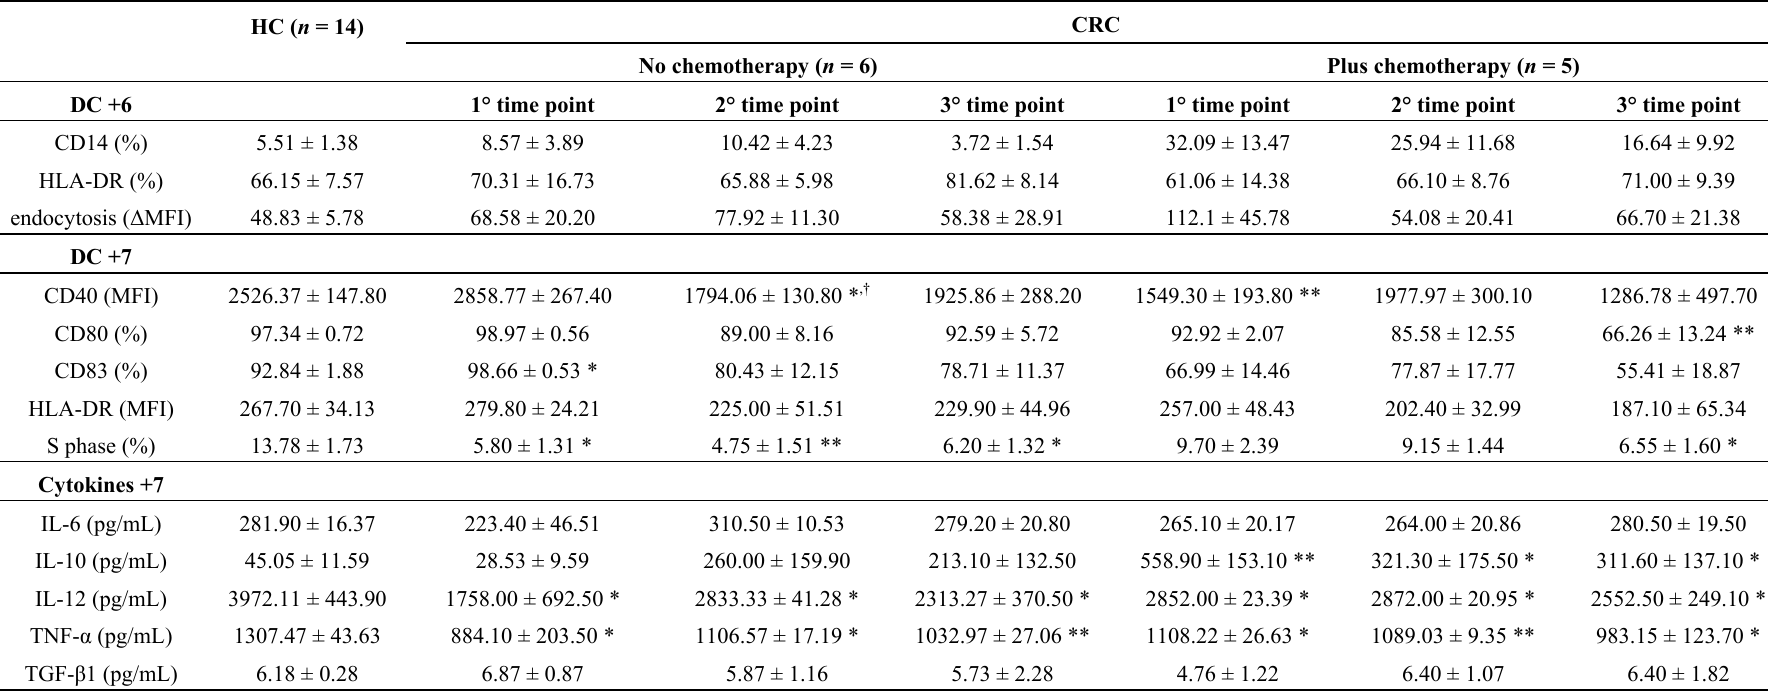
Table 4. Comparison of data from healthy controls and CRC patients among the three